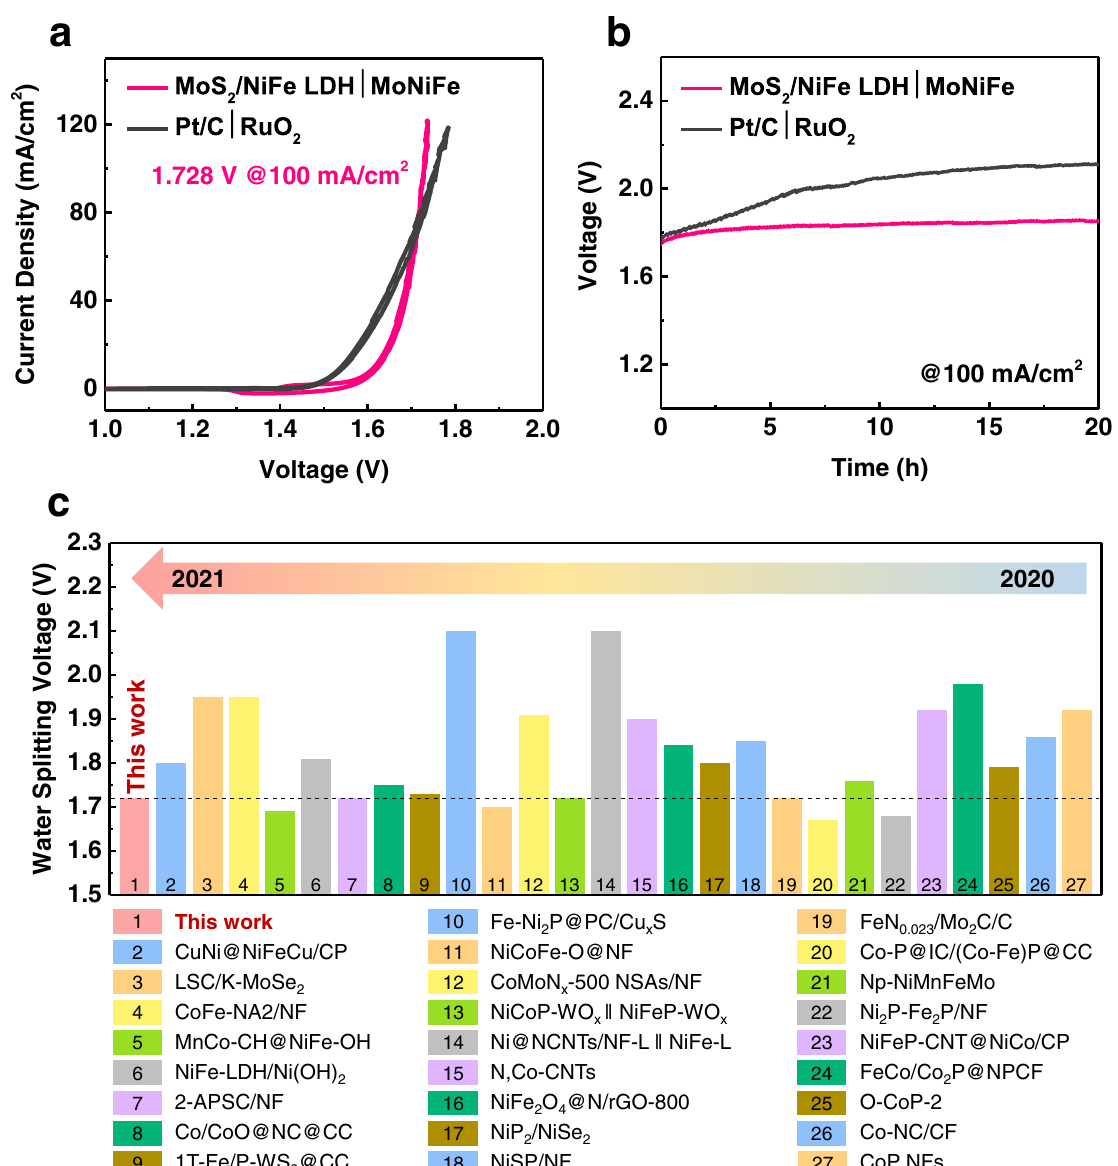
Fig. 7 The overall water splitting performance. a Polarization curves of the electrolytic cell with MoS 2 /NiFe LDH | MoNiFe coupled electrodes and the reference cell with Pt/C | RuO 2 coupled electrodes for overall water splitting. b Chronopotentiometry curves at the current density of 100 mA/cm 2 of the electrolytic cell with MoS 2 /NiFe LDH | MoNiFe coupled electrodes and the reference cell with Pt/C | RuO 2 coupled electrodes. c The comparison of overall water splitting performance at the current density of 100 mA/cm 2 for MoS 2 /NiFe LDH | MoNiFe and other noble-metal-free electrocatalysts in recently reported literature, such as MnCo-CH@NiFe-OH (1.69 V) 61 , NiFe-LDH/Ni(OH) 2 (1.81 V) 62 , NiCoFe-O@NF (1.7 V) 63 , NiP 2 /NiSe 2 (1.8 V) 64 ,